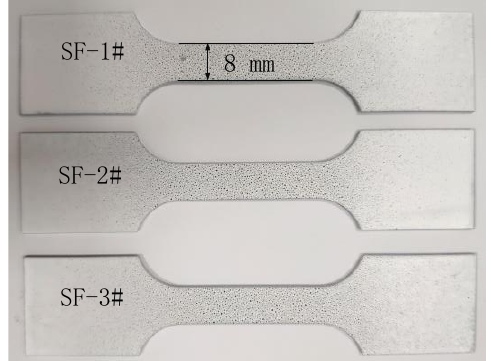
Figure 7. The SF specimens.